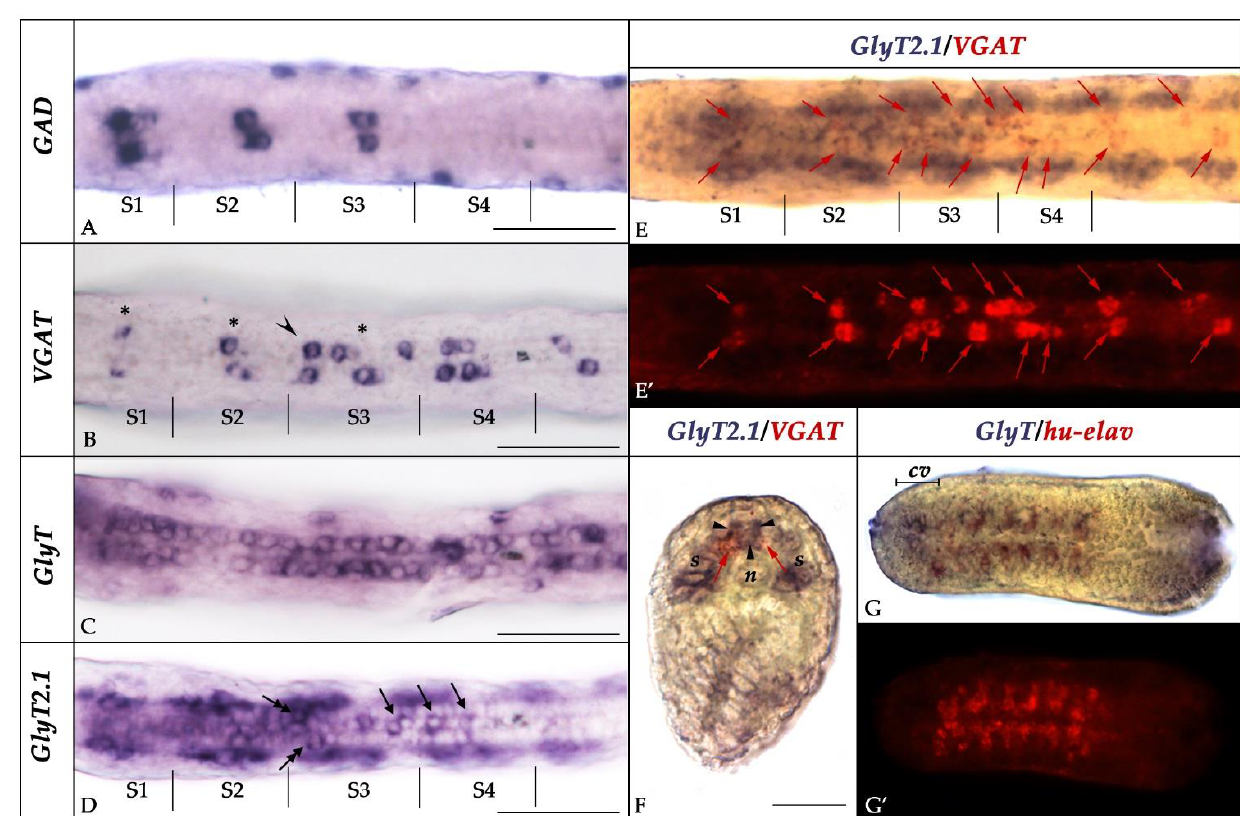
Figure 6. Position of cells expressing glycine transporter genes and neurochemical markers. ( A – D ) Dorsal view of the posterior cerebral vesicle and anterior rhombospinal region of T1-stage embryos showing expression of GAD , VGAT , GlyT , and GlyT2.1 with indicated position of the boundaries of the anteriormost somites (S1, S2, S3, S4). Asterisks in ( B ) indicate GAD -expressing cells, whereas arrowheads indicate GAD -negative/ VGAT -positive cells. In ( D ), arrows indicate GlyT2.1-positive cells along the midline, whereas double-headed arrows highlight cells that are located more laterally than those expressing GAD , VGAT or GlyT . ( E – E’ ) T1-stage embryo stained for GlyT2.1 (purple) and VGAT (red) viewed in brightfield ( E ) and fluorescence ( E’ ). Enlargement of the same region as shown in ( A – D ). Red arrows indicate cells expressing VGAT . ( F ) Cross-section of the embryos shown in ( E ), at the level of somite 2. VGAT (red arrows) and GlyT2.1 (arrowheads) are not co-expressed in the same cells. ( G – G’ ) N4-stage neurula stained for GlyT and hu-elav viewed in brightfield ( G ) and fluorescence ( G’ ). GlyT and hu-elav are co-expressed in the rhombospinal region, but not in the anterior cerebral vesicle. Abbreviations: cv: cerebral vesicle; n: notochord; s: somite. The scale bar is 25 µm in ( F ) and 50 µm in all other panels.